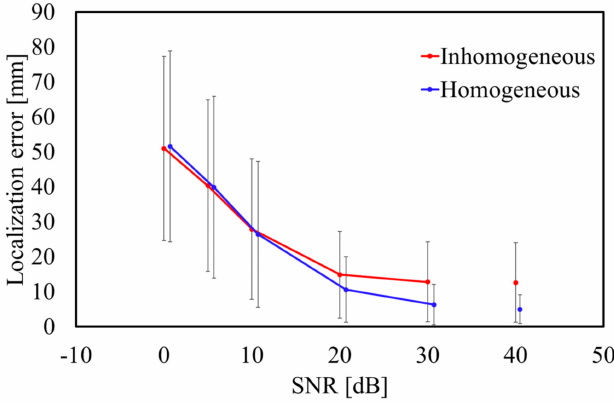
Figure 7. Average LE for different SNRs. Error bars represent the standard